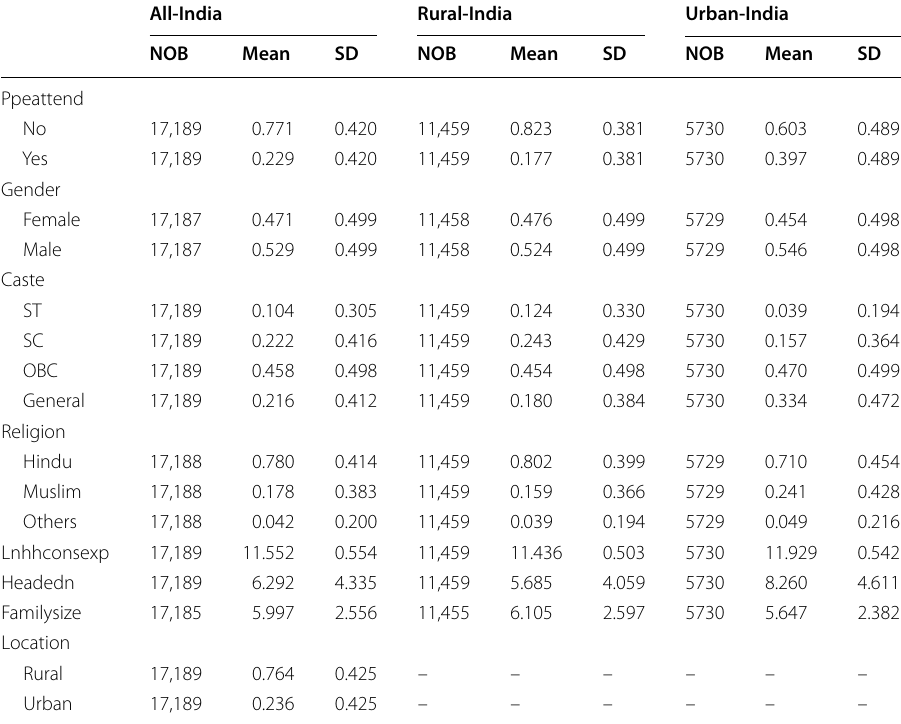
Source: Authors’ estimation from 75th NSO round data, 2017–2018